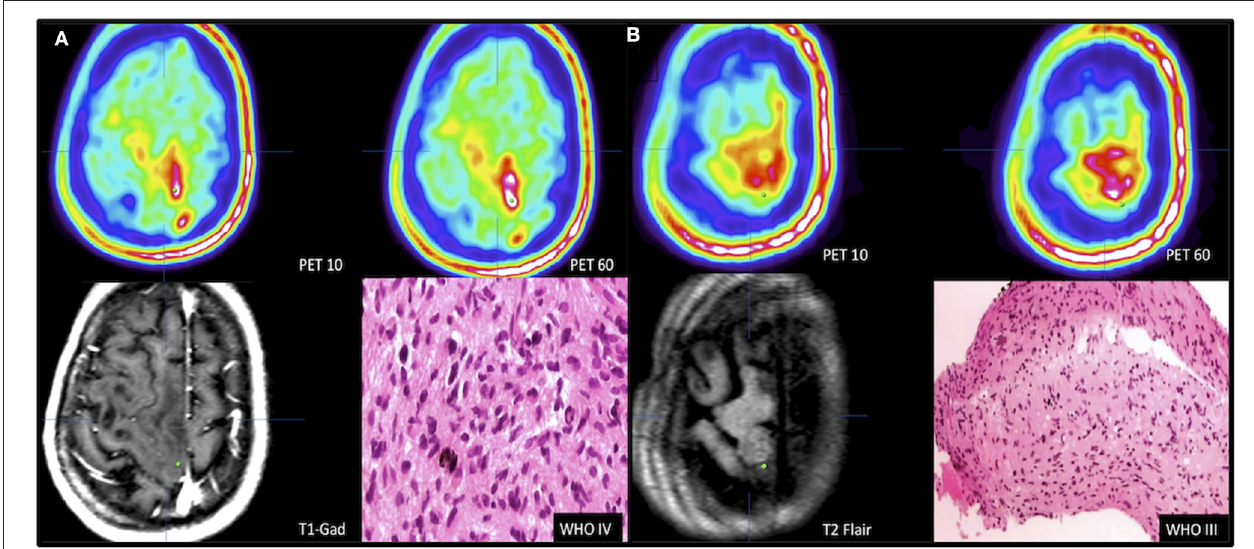
FIGURE 3 | Selection of biopsy target based on dual time point. Patient 2 presented with tumor of eloquent area. Target of highest malignancy (A) was selected using FET kinetics defined in dual time-point PET images with no contrast enhancement in the T1-CE sequence. PET10 lesion defined by FET uptake hotspot (1.88 SUV) was expected to be highly malignant (white area); PET60 lesion defined by coexistence of hotspots (white areas) (2.64 SUV). Biopsy target marked by a green dot. Biopsy from hotspot of early occurrence showed GBM. (B) Defining the tumor border by targeting the tumor periphery (green dot, PET10 1.26 SUV and PET60 1.1 SUV) in area of moderate FET uptake visible on dual time-point PET with no contrast enhancement in T1 + gadolinum sequence and no clear changes visible on T2-FLAIR MRI image. Biopsy result was grade III